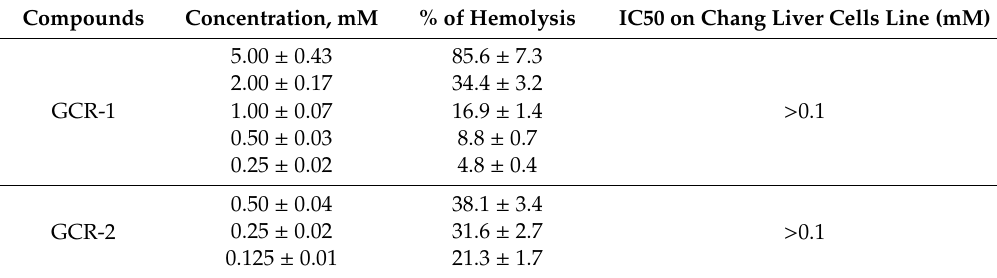
Table 3. Cytotoxic e ff ects of GCR-1 and